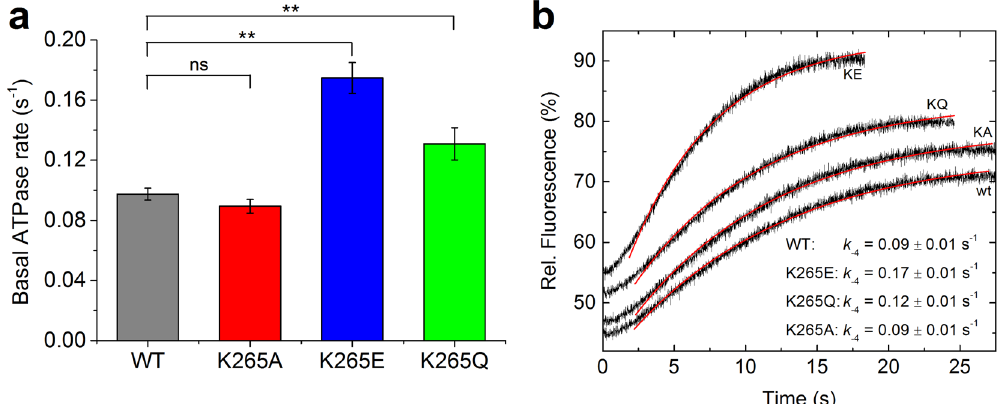
Figure 2. Basal ATPase activity and basal P i -release of WT and mutant myosins. ( a ) The basal ATPase rate was determined in the absence of actin. Error bars give the standard deviation for 3–6 independent experiments. The differences obtained for K265E and K265Q were highly significant ( ** for p < 0.005). ( b ) The basal P i - release rate k -4 is the rate limiting step of the basal Dd myosin-2 ATPase cycle and was measured using a fluorescent P i detection system. The obtained kinetic parameters are summarized in Table 1(a) and Table 2(b).